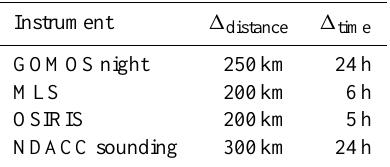
Table 3. Coincidence criteria for the GBL and correlative measure-